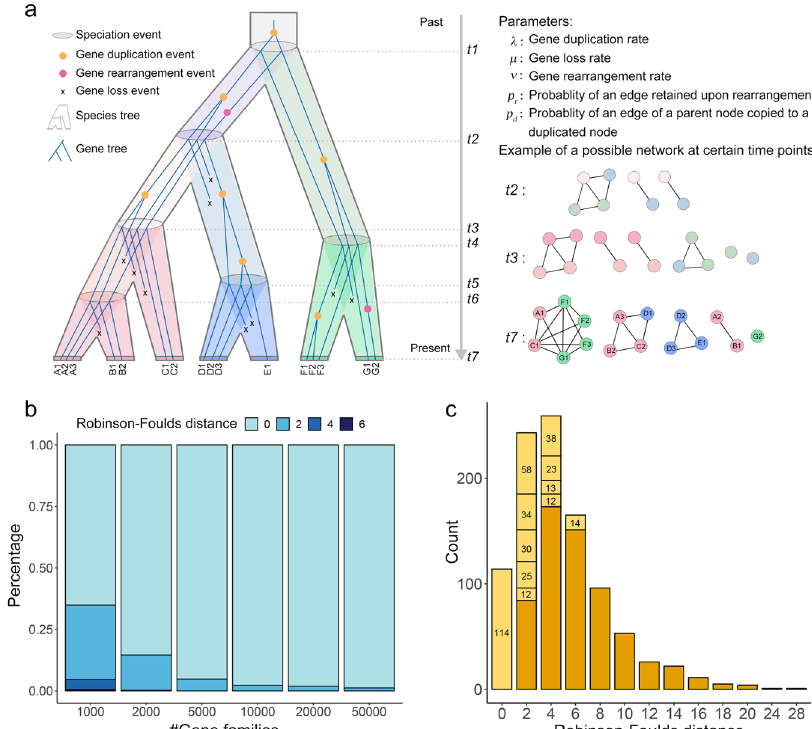
Fig. 2 Results of Syn-MRL on simulations. a Simulation process. An evolutionary scenario for a single gene family is illustrated, involving gene duplication, loss, and rearrangement. Extant gene names are labeled at the bottom (left panel). Nodes and edges of synteny clusters are simulated in stages under the listed parameters, ‘ snapshots ’ of the evolution of the associated gene family synteny network are shown at three-time points right after a speciation event (right panel). For example, at t2 , three connected components can be formed: a ‘ conserved ’ four-node cluster, and two ‘ speci fi c ’ two-node clusters, which were formed as a result of the gene duplication or rearrangement events that happened between t1 and t2 . b Proportions of inferred trees with a particular RF distance to the true 15 monocot species tree. Simulations were conducted for different numbers of total gene families, with 1000 replicates for each simulation. c Distribution of RF distances of the inferred trees to the true 62 plant species tree. A total of 1000 simulation replicates of 1000 gene families were conducted. The 10 most frequently recovered topologies are labeled within the corresponding bar of the